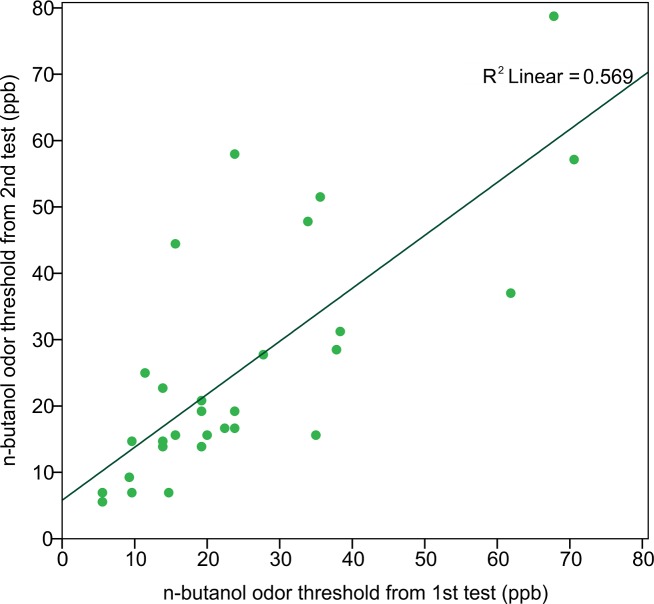
Correlation of n-butanol olfactory threshold scores obtained from participants tested twice, 14 to 18 weeks apart.